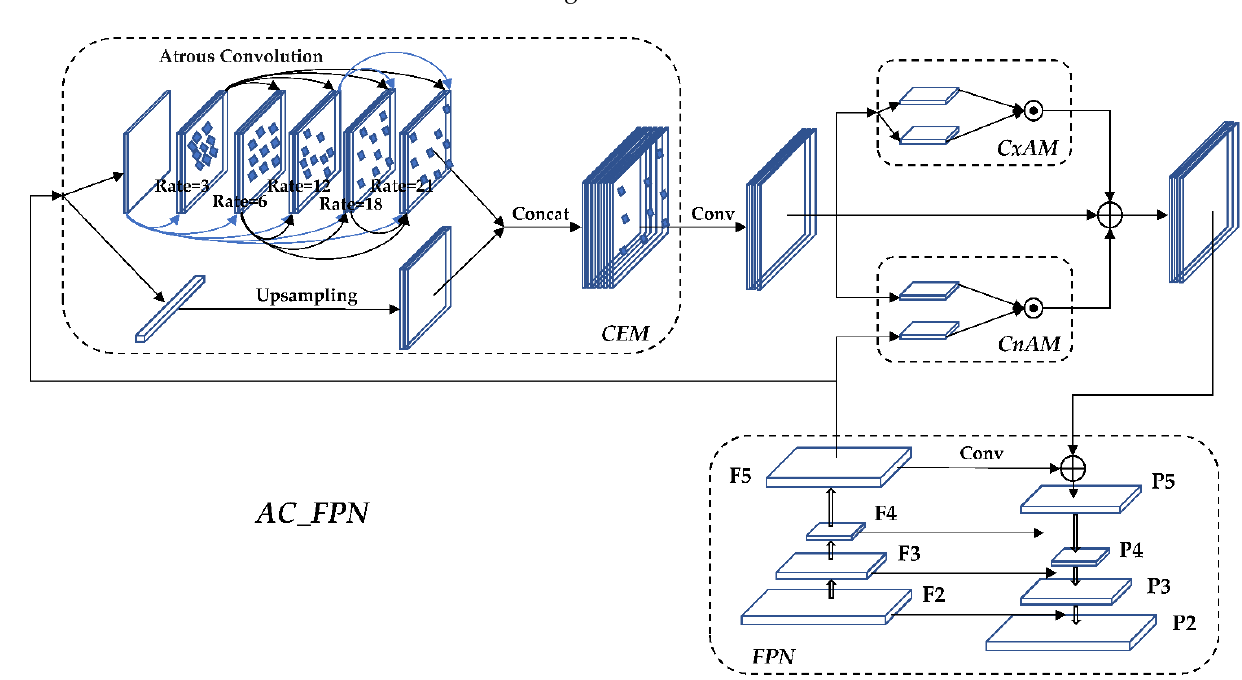
Figure 11. AC_FPN structure diagram.